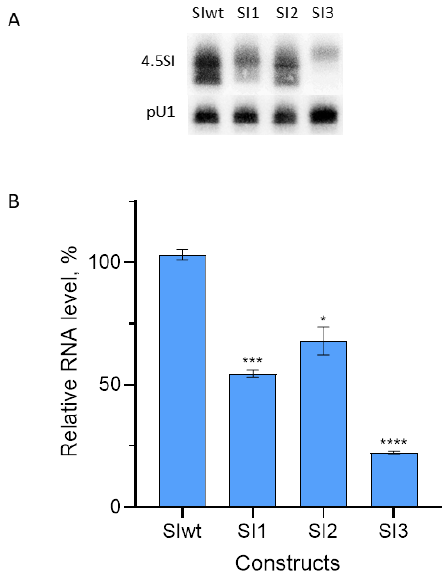
Figure 5. Transcription of 4.5SI RNA gene and its three derivatives with modified A or B boxes in the transfected HeLa cells. ( A ) Detection of 4.5SI RNA and its derivatives, as well as pU1 (control,) via Northern hybridization. ( B ) Quantitative analysis of the hybridization data. The level of wild-type 4.5SI RNA (SIwt) is taken as 100%. Error bars, SD, n = 3, t -test: *— p < 0.05, ***— p < 0.005, ****— p < 0.0001.